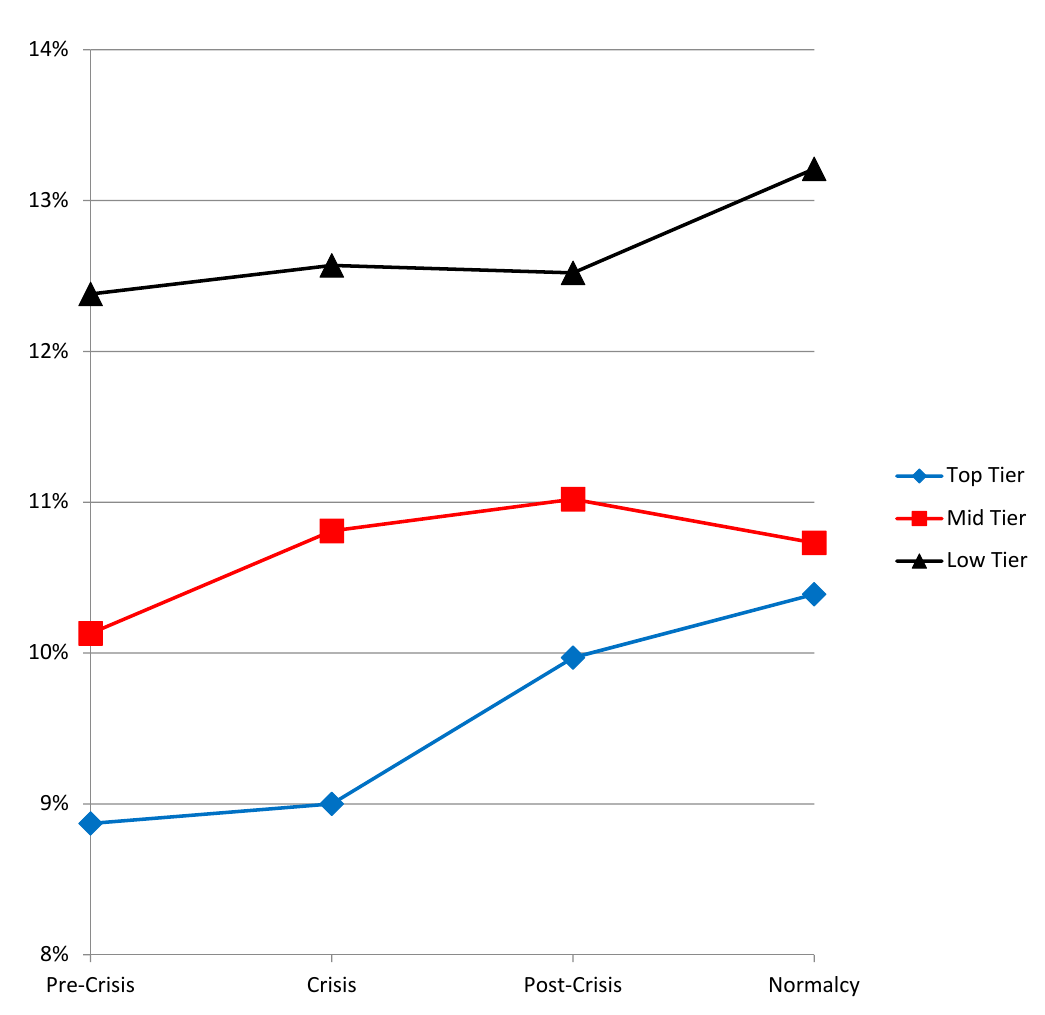
Figure 3. Shareholder Equity/Total Assets Ratio. Notes: Top-Tier: JPMorgan Chase, Bank of America, Citigroup, Wells Fargo; Mid-tier: Bank of New York Mellon, State Street, US Bancorp, PNC Financial Services Group; Low-tier: Capital One Financial, BB&T, SunTrust Banks, Regions Financial. Pre-crisis: 2005–2007; Crisis: 2008–2010; Post-Crisis: 2011–2013; Normalcy: 2014–2016. Data obtained from published financial